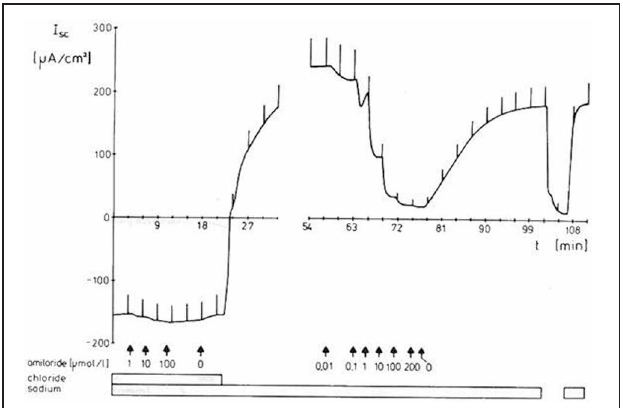
FIGURE 5 | Independent absorption of Na + and Cl − in a hyperosmoregulators characterized by a low conductance (“tight”) gill epithelium. Representative time-course of the short-circuit current (I sc ), showing the negative I sc [reflecting active and Na + -independent Cl − -absorption; further characterized in Onken et al. (1991)] and the positive I sc [reflecting Cl − - independent Na + -absorption; further characterized in Zeiske et al. (1992)] across a split gill lamella of the Chinese crab Eriocheir sinensis . Current deflections are due to 10mV voltage pulses and are directly proportional to the transepithelial conductance (from Zeiske et al., 1992).